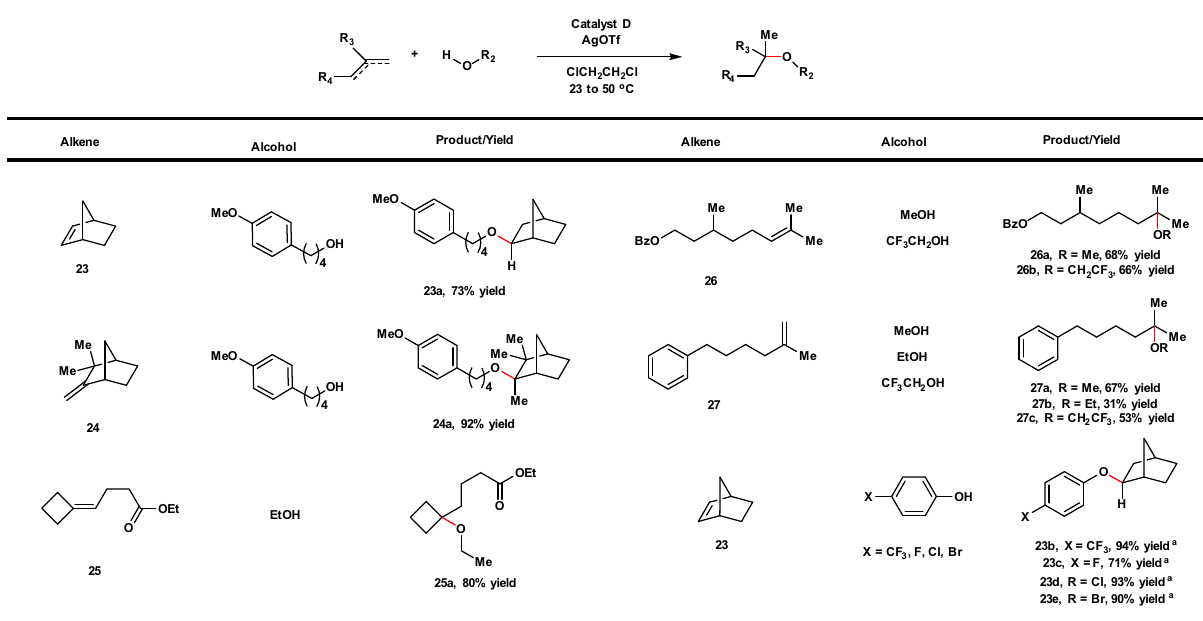
Fig. 4 Substrate scope for intermolecular hydroalkoxylation. General conditions: catalyst D (5 mol%), AgOTf (6 mol%), 50 °C, 16 – 24 h. Yields of isolated products were given. a Catalyst D (2 mol%), AgOTf (3 mol%), 23 °C, 24